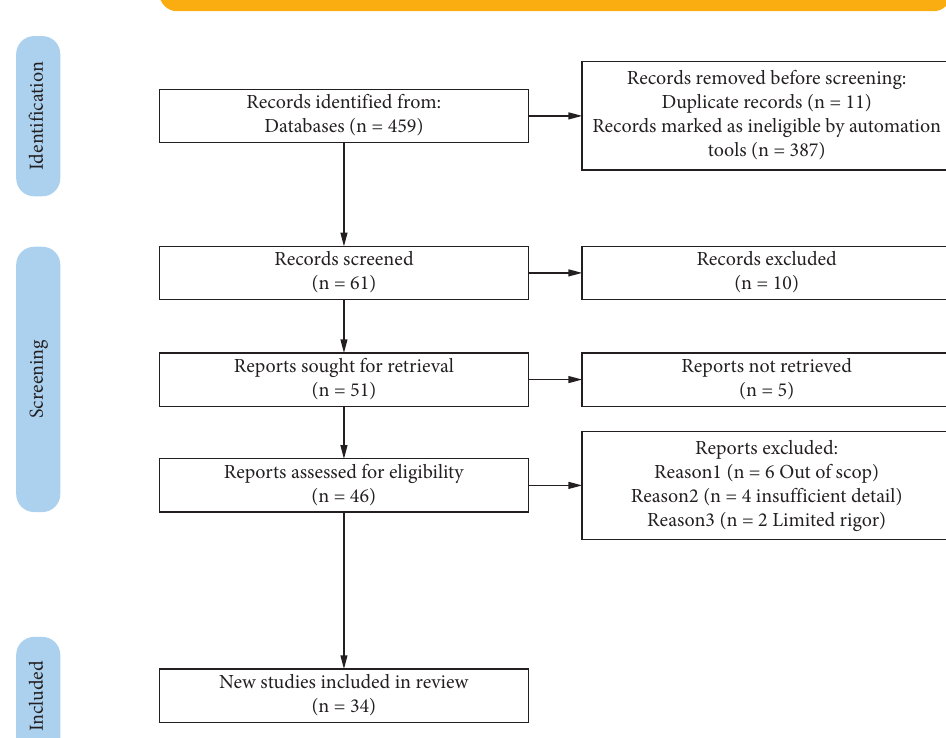
Figure 1: The PRISMA flow diagram showing the flow of information in the procedure of including studies in this